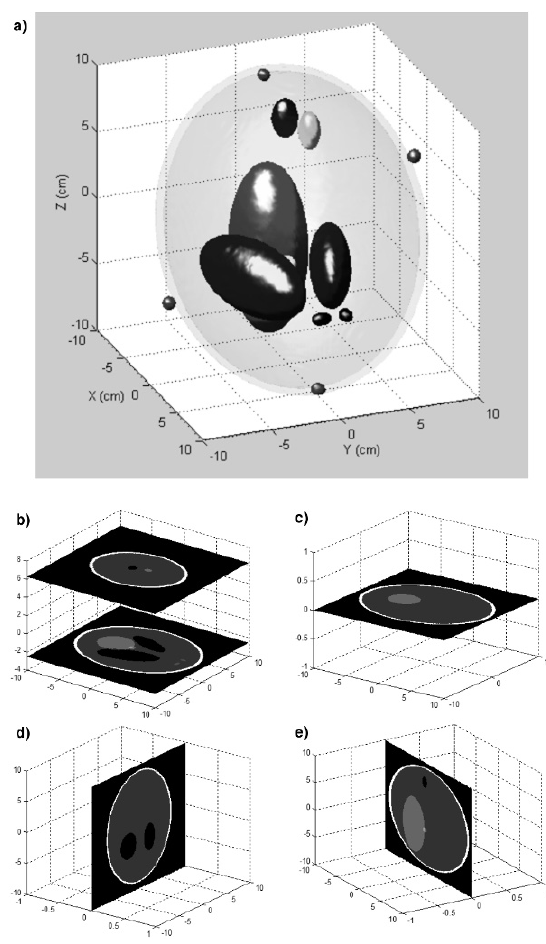
Figure 1. (a)a3DversionoftheShepp-Loganphantomwithmarkers; (b) axial slices at Z = − 2.5 cm and 6.25 cm; (c) axial slice at Z = 0; (d) coronal slice; (e) sagittal